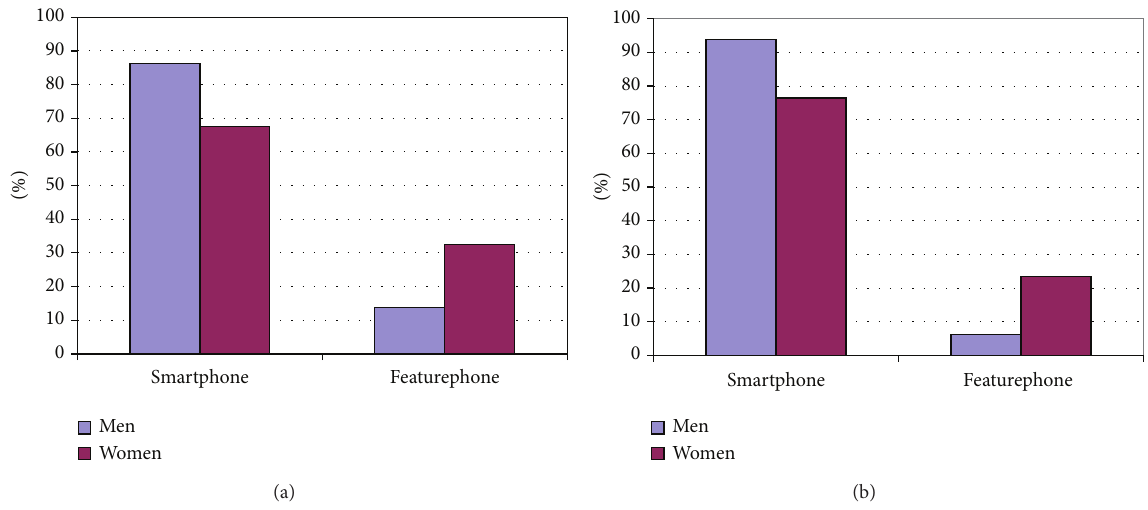
Figure 1: Technological equipment: smartphone penetration among digital natives (a) and digital immigrants